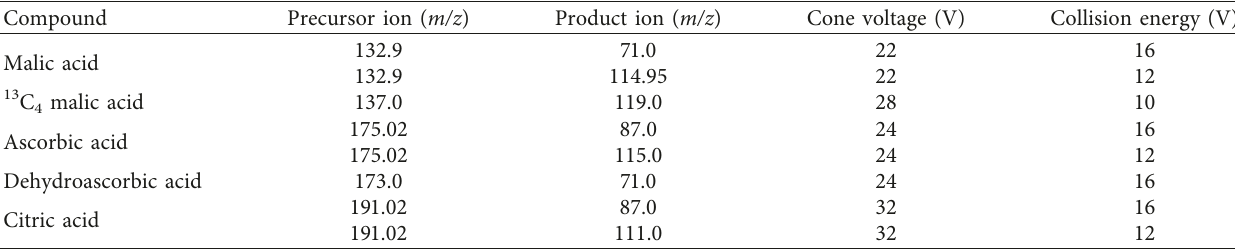
Table 1: MRM parameters for organic acids.